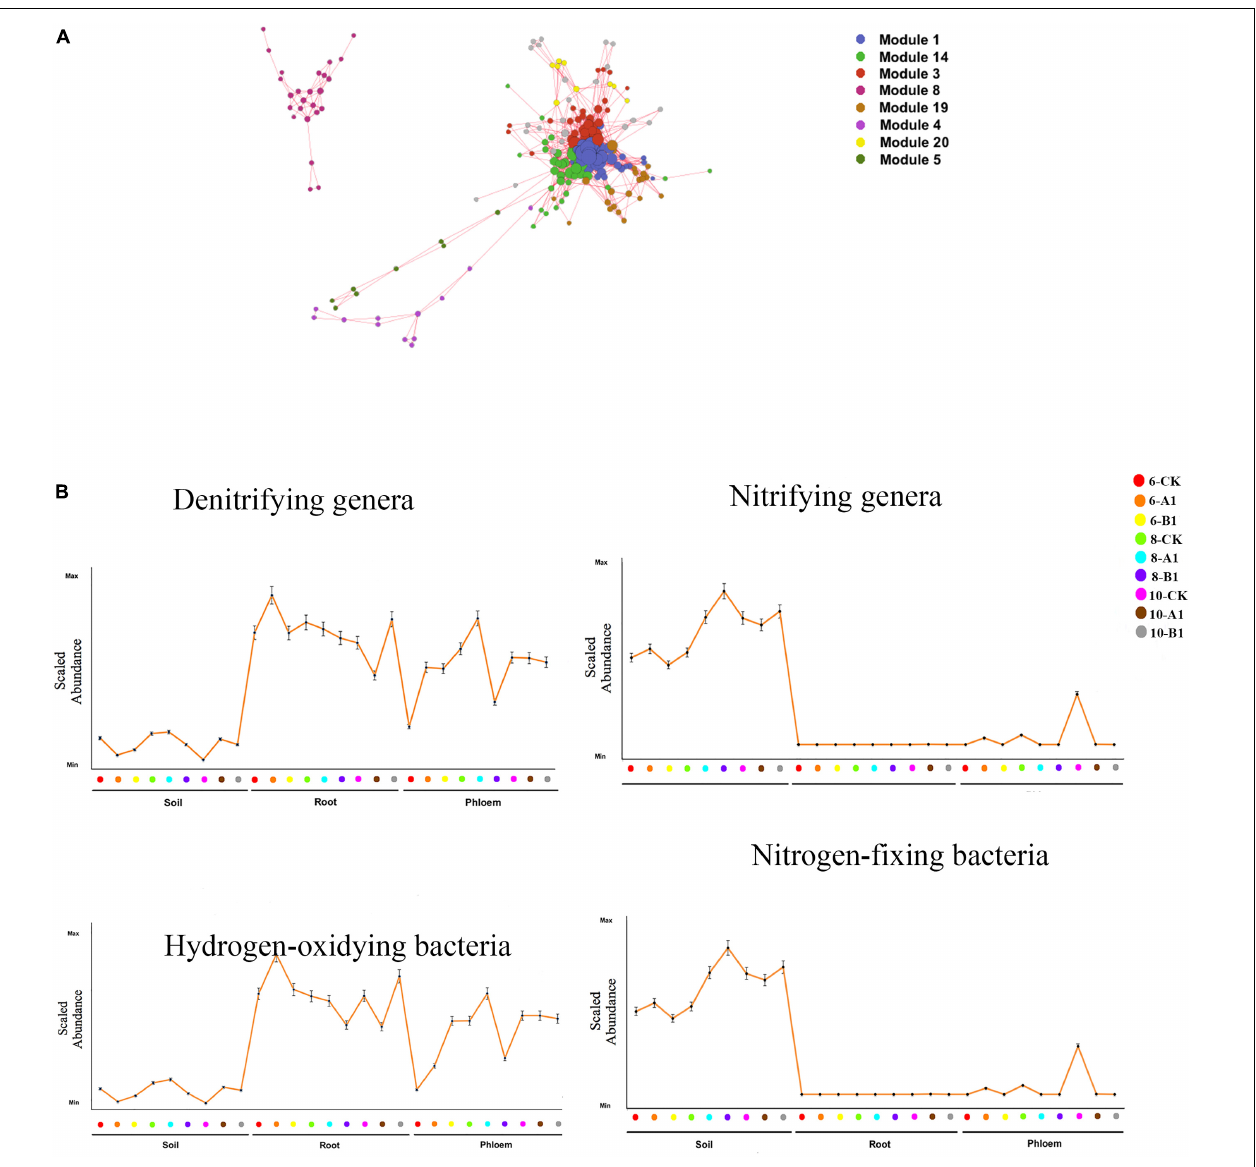
FIGURE 8 | Functional analysis of the bacterial communities. (A) OTU co-abundance network revealing the modules of OTUs associated with functional bacteria. Only uniquely associated OTUs or those associated with all four functional genera and with significant associations (i.e., correlation greater than 0.5) are shown. Each node represents an OTU, and each module is displayed in a different color. (B) Mean abundance profile for the OTUs in the functional bacteria groups across different samples. The position along the x -axis corresponds to different samples. Error bars represent the SE. The x - and y -axes have no